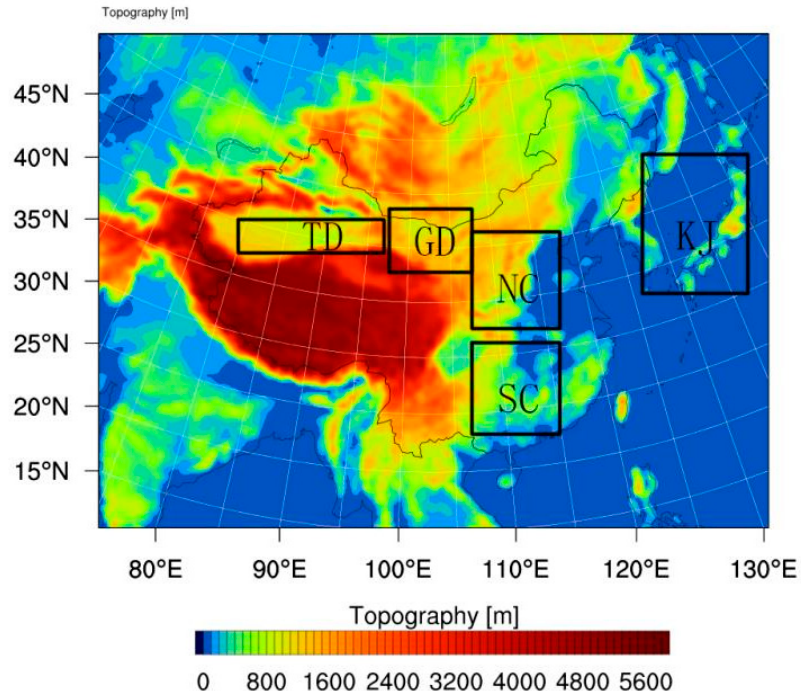
Figure 1. Topographical map of the study domain. Homogenous regions highlighted in black boxes include: (1) the Taklimakan Desert (TD), (2) the Gobi Desert (GD), (3) Northern China (NC), (4) Southern China (SC) and (5) Korea-Japan (KJ).